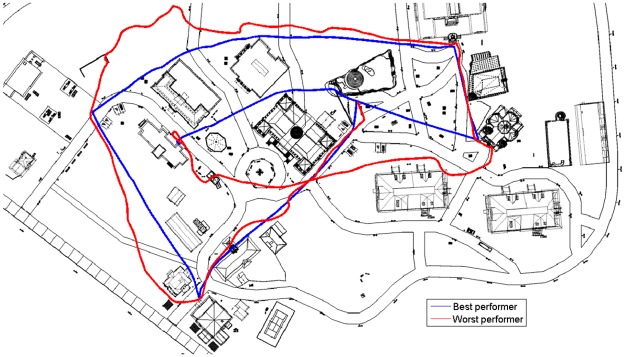
Paths of best and worst participants during testing.The blue line traces the path of the best-performing participant. No wrong turn was taken and nearly no deviations occurred on straight paths. The red line traces the path of the worst-performing participant. Many wrong turns and unnecessary deviations from straight paths can be observed.